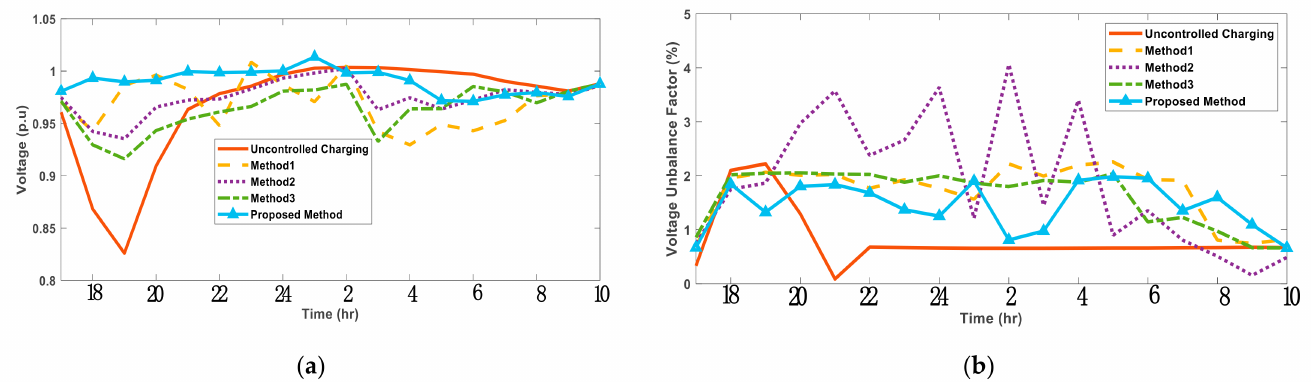
Figure 17. Bus 846 ( a ) voltage and ( b ) VUF for price signals in the winter season.